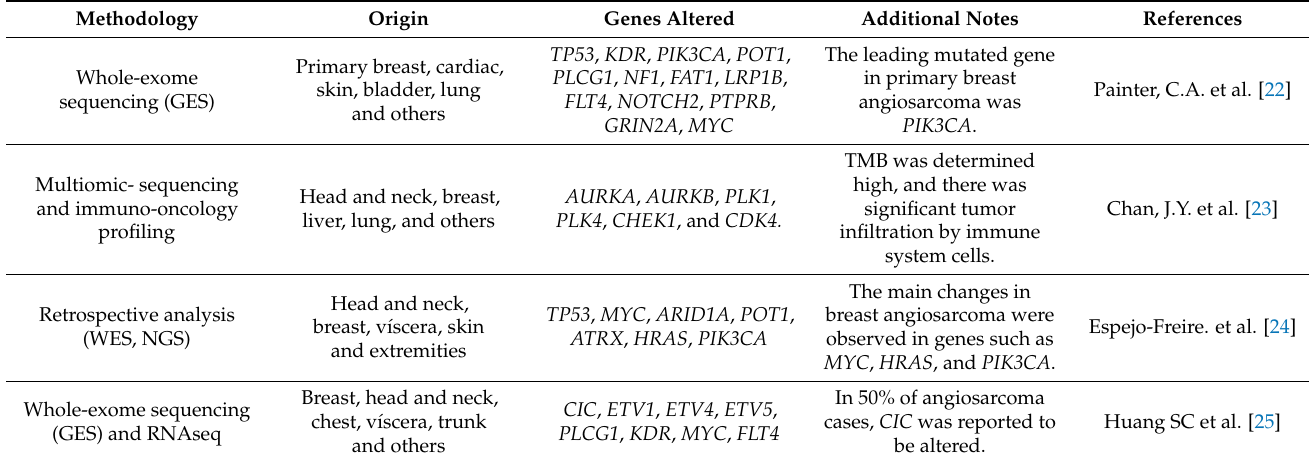
Table 2. Results of genomic and transcriptomic studies in different types of angiosarcomas.